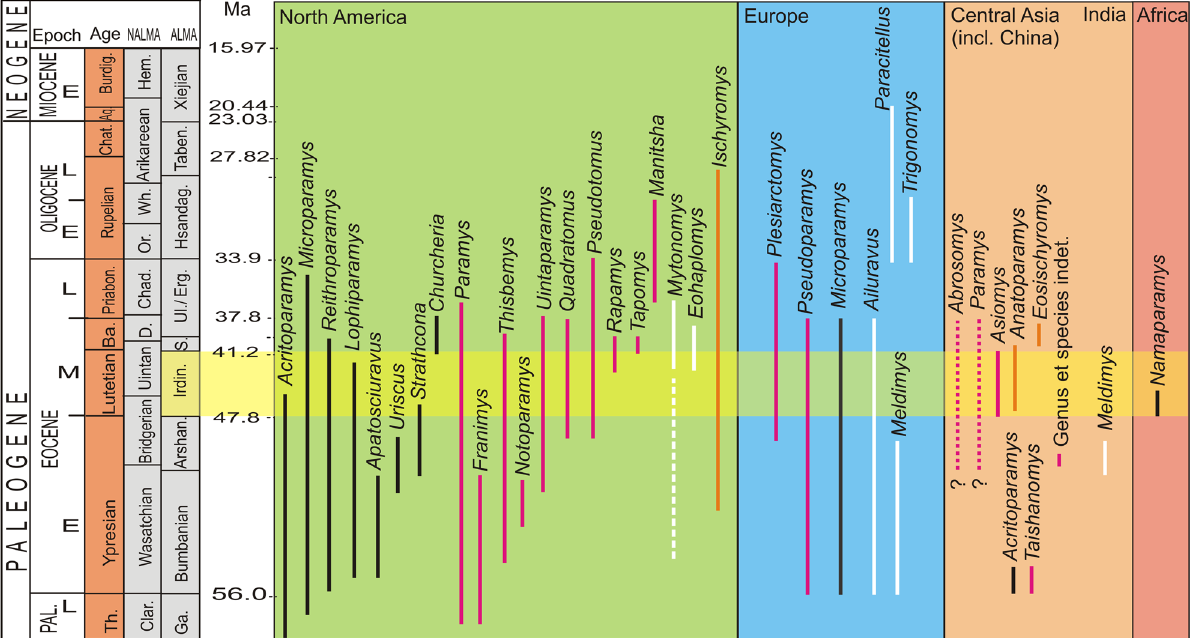
Figure 5. Temporal ranges of Ischyromyidae. Color of range line denotes subfamily: black, Microparamyinae; pink, Paramyinae; orange, Ischyromyinae; white, Ailuravinae; yellow stripe marks the Irdinmanhan ALMA. Geological and stratigraphic chart based on Woodburne 11 , Ni et al. 52 , and Cohen et al. 64 ; classification based on Anderson 6 and McKenna and Bell 65 . For fossils age data, see the text. (Drawing made in Corel Draw X4 (v.14.0.0.567) by Łucja